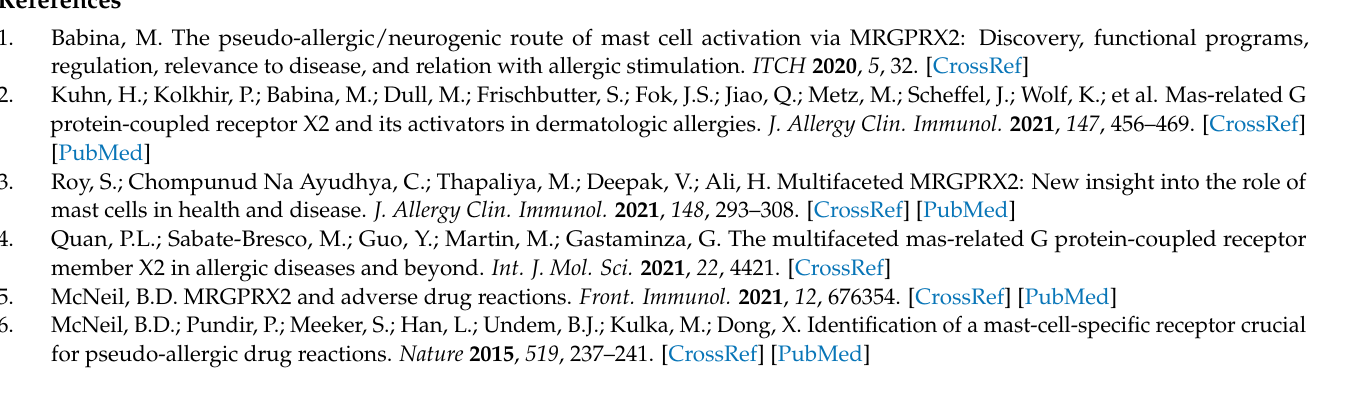
Figure 1 exert no cytotoxicity on cultured skin MC; Figure S2: MC degranulation via MRGPRX2 relies on G α i, G α q and calcium mobilization as evidenced by histamine release; Figure S3: The survival of ex vivo skin MC is not perceptibly compromised by the inhibitors employed in main Figure 1; Figure S4: Differences between c48/80 and SP from main Figure 1; Figure S5: Comparison between cultured and ex vivo skin MCs from main Figure 1; Figure S6: The inhibitors employed in main Figure 2 exert no cytotoxicity on cultured skin MC; Figure S7: The survival of ex vivo skin MCs is not perceptibly compromised by the inhibitors employed in main Figure 2; Figure S8: Differences between c48/80 and SP from main Figure 2; Figure S9: Comparison between cultured and ex vivo skin MCs from main Figure 2; Figure S10: c48/80 activated pERK depends on G α i, G α q, and Ca++, while pAKT exclusively requires the action of G α i only—normalization against actinin; Figure S11: Interconnections between early and later signals induced by SP are comparable to those elicited by c48/80—normalization against actinin; Figure S12: Interconnections between early and later signals induced by c48/80 and SP in ex vivo MCs; Figure S13: Ca++ channel inhibition boosts AKT activation downstream of IgER-CL—normalization against actinin; Table S1: Inhibitors employed and their primary targets. References [15,30,31,33,36,38,39,44,49,51,55,60–62,86–96] are cited in